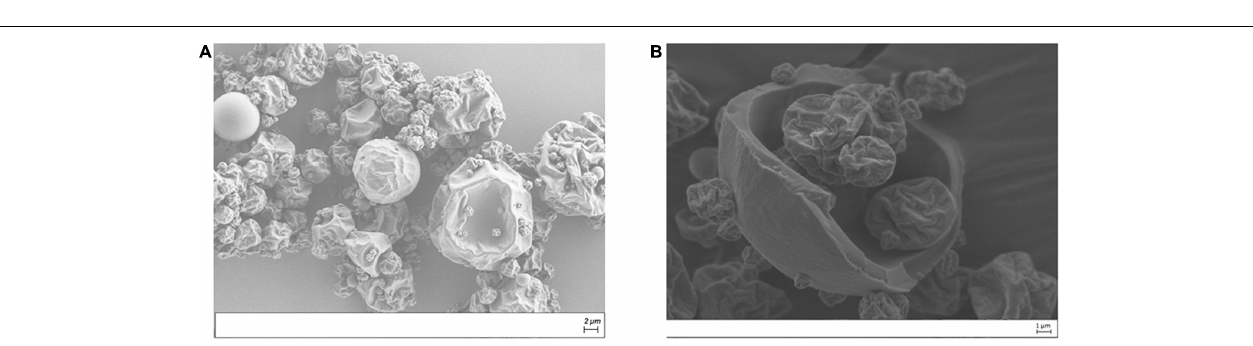
FIGURE 1 | Zeta potential of RuL3 as a function of pH (imidazole/acetate buffer, 5 mM). Data are presented as means ( ± SD) of three independent repextineats in triplicate.